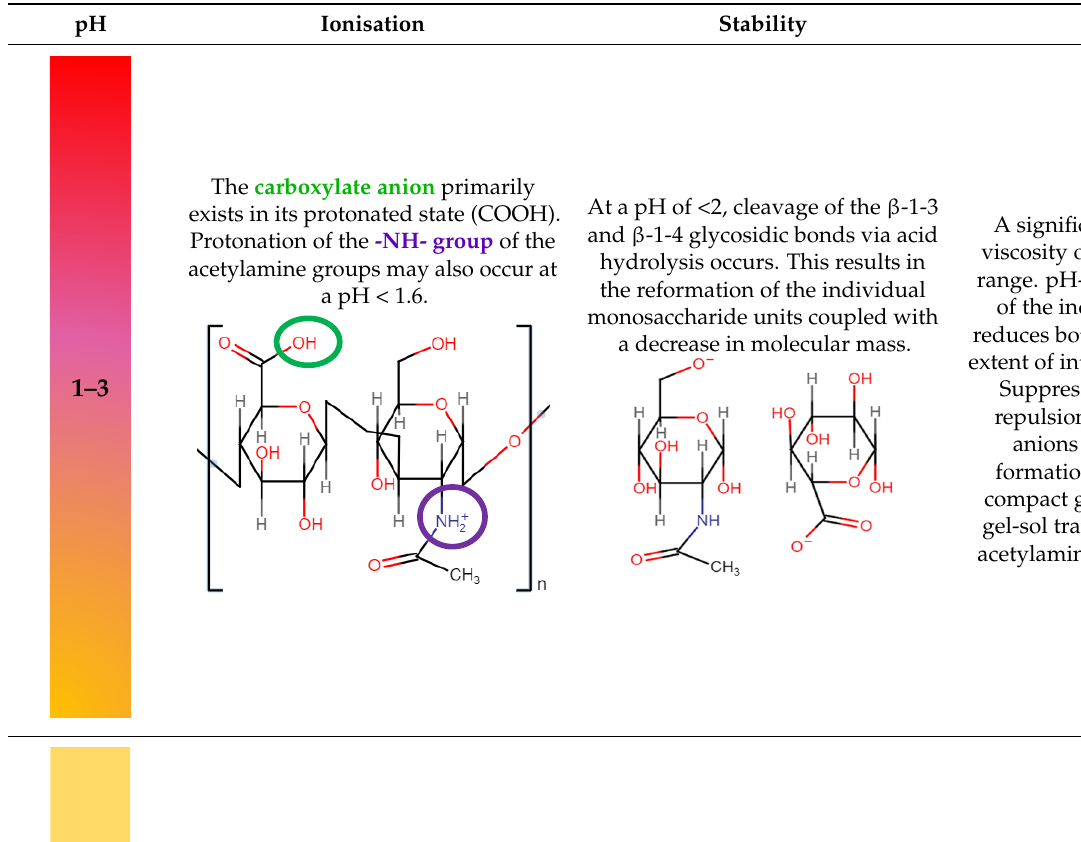
Table 1 . The physicochemical state of HA from pH 1 to 14 [65–68].